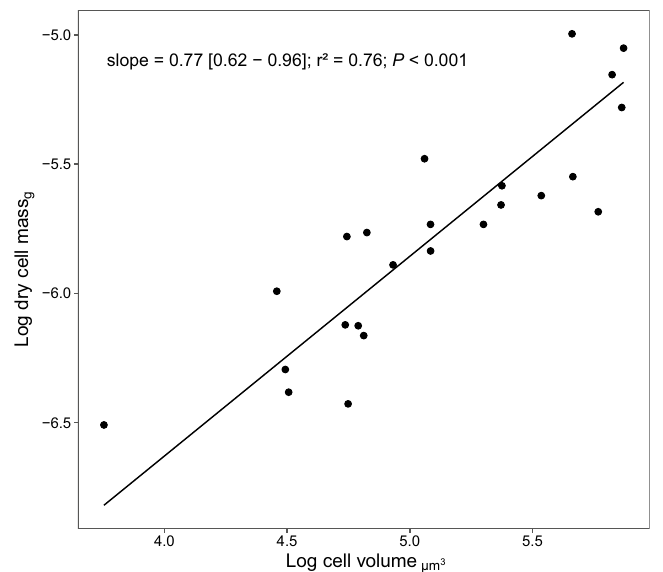
Figure 3. Sublinear scaling of dry cell mass to volume in 24 species of Micrasterias . Both variables are log-10- transformed. Each dot represents the average value of a given species. The black line represents SMA regression.